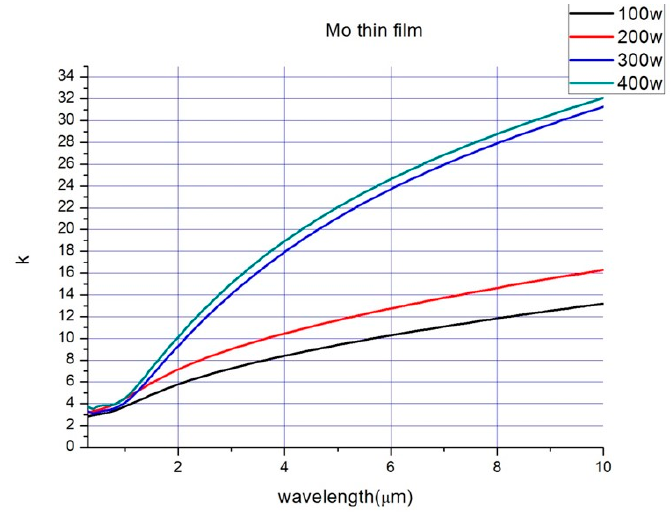
Figure 9. The extinction coefficient of the Mo absorption layer for different deposition powers.